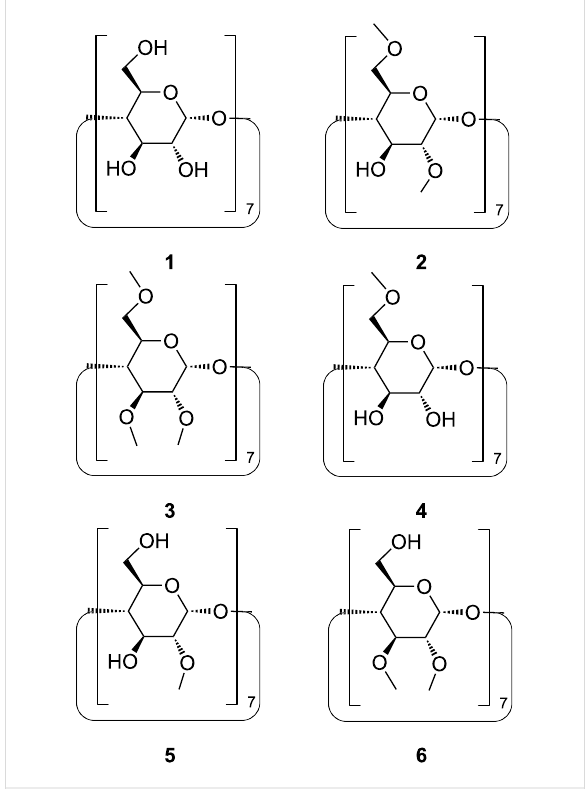
Figure 1: Structures of the methylated β -CD derivatives investigated.